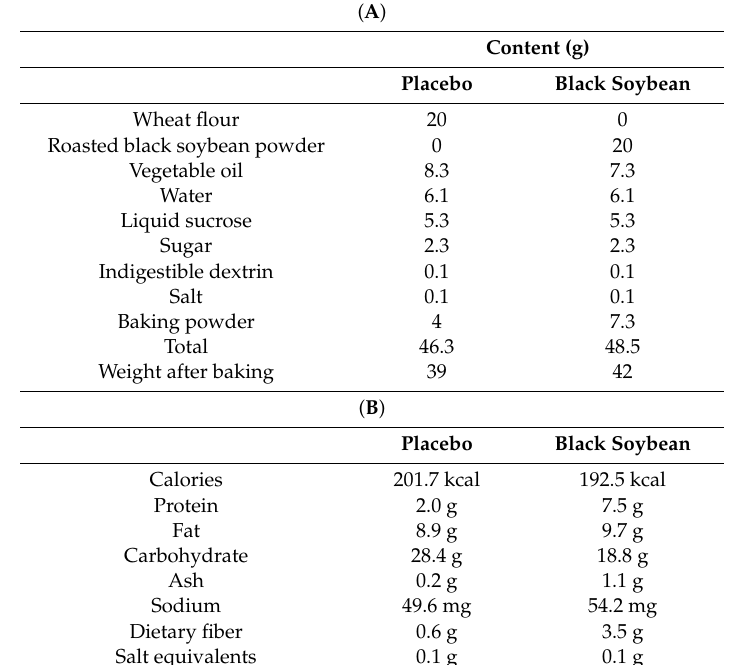
Table 1. ( A ) Composition of test cookies, ( B ) nutritional composition of test